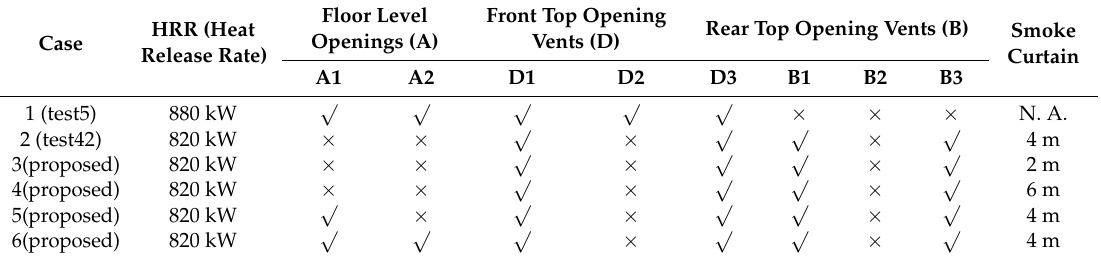
Table 1. Numerical simulation cases and configurations for the fuel bed, opening vents, and smoke curtain.